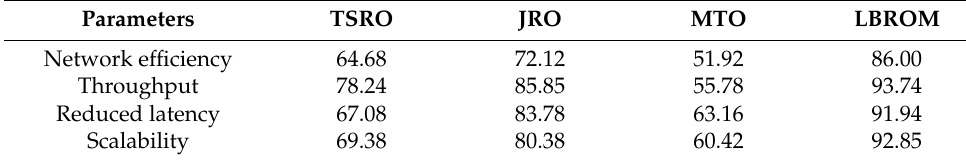
Figure 6. Comparison of scalability. Table 3. Comparison of scalability (in %) .